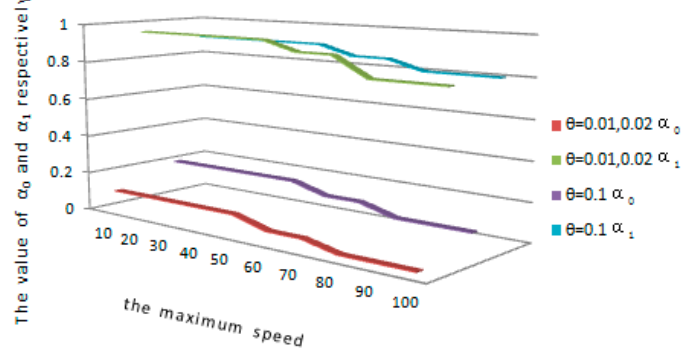
Figure 4. The configurations of α 0 and α 1